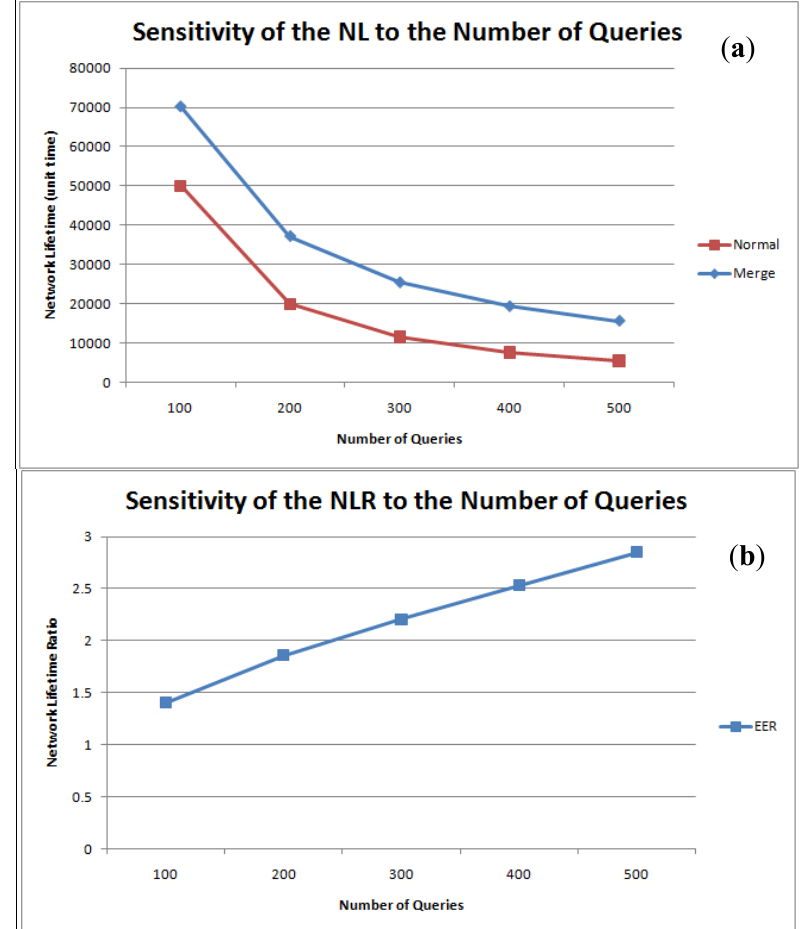
Figure 14. Sensitivity of the (a) Network Lifetime and (b) NLR to the number of